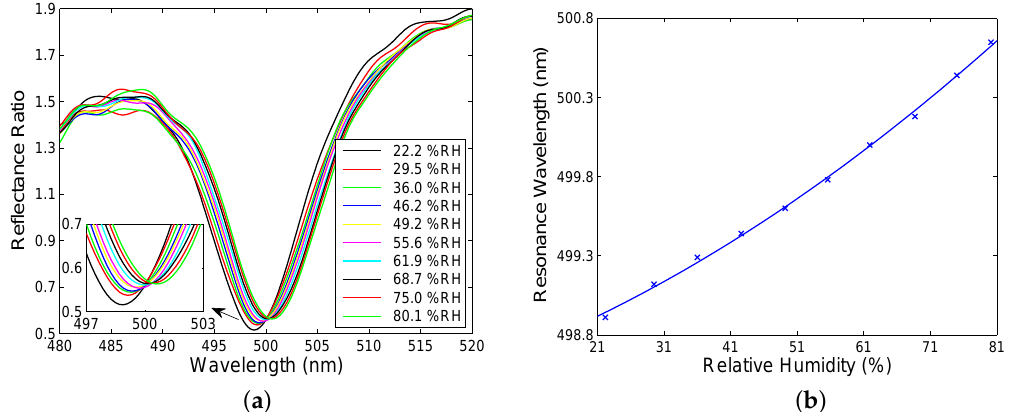
Figure 9. Spectral reflectance ratio R PA45 ( λ ) / R s ( λ ) for different values of the RH of moist air measured within the short-wavelength band gap (BSW1) ( a ). Resonance wavelength as a function of the RH of moist air with a polynomial fit ( b ).